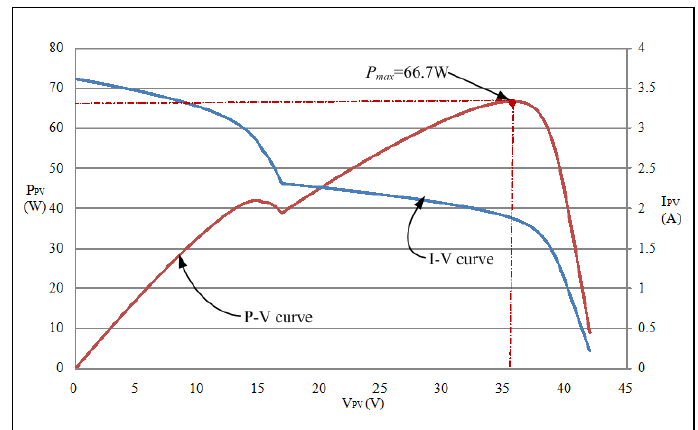
Figure 11. I–V and P–V characteristic curves of the two-serial and two-parallel module array with [(0% and 30% shading)//(0% and 50% shading)].